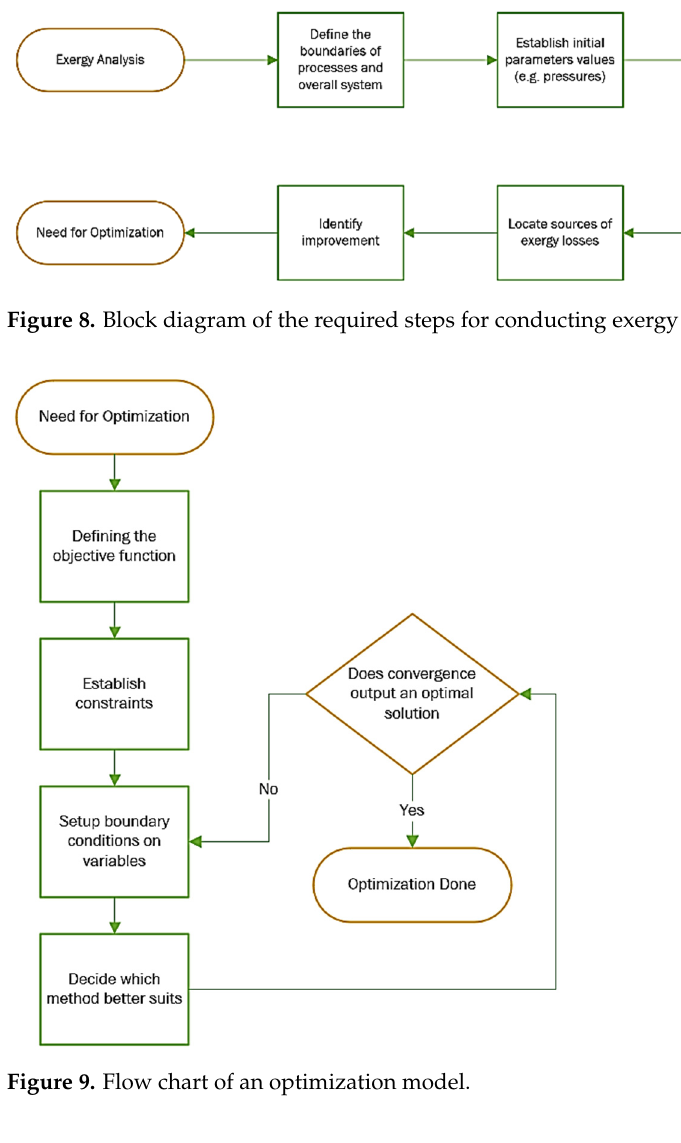
Figure 7. Classification of optimization problems.